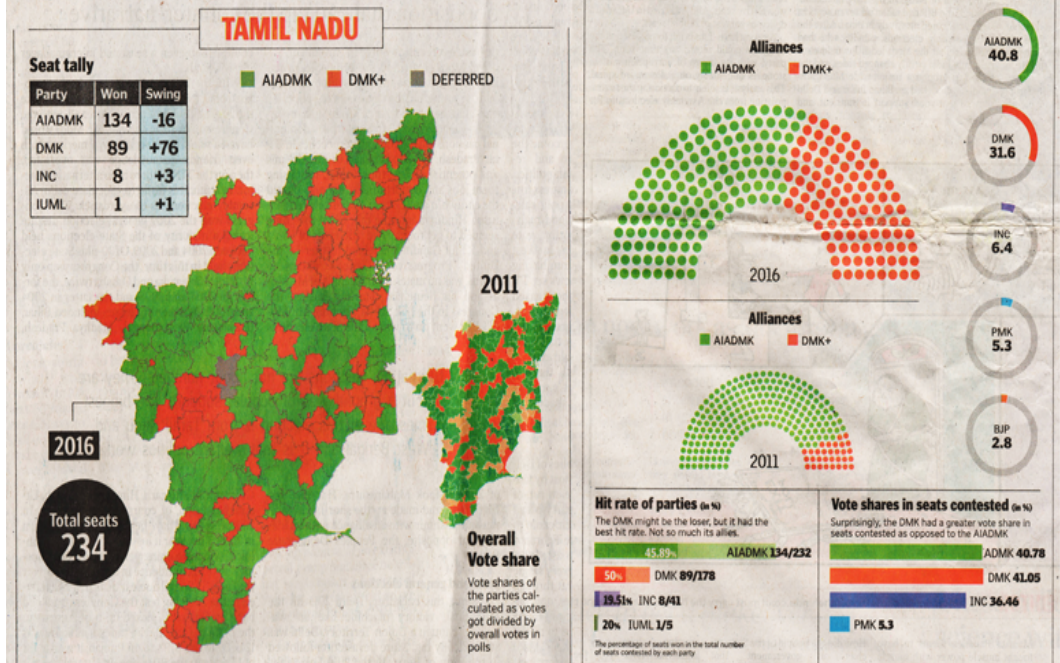
Figure 4: Tamil Nadu Assembly Elections 2016 Coverage by The Hindu